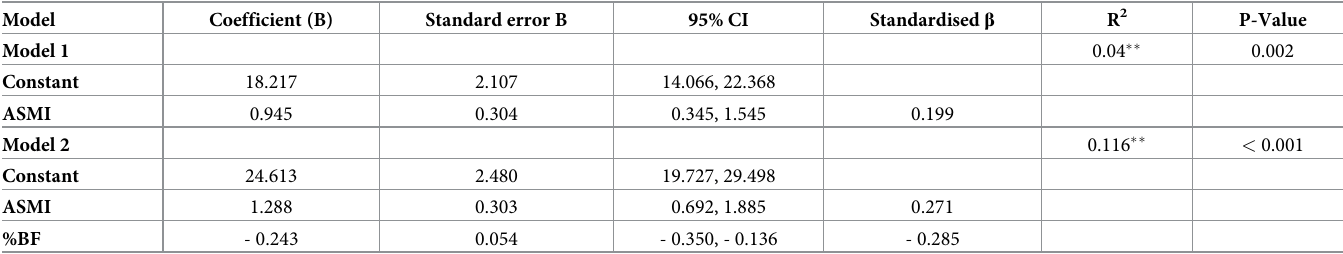
Table 2. Results of multiple linear regression modelling on the relationship between muscle strength, mass and body fat percentage in older females. Model